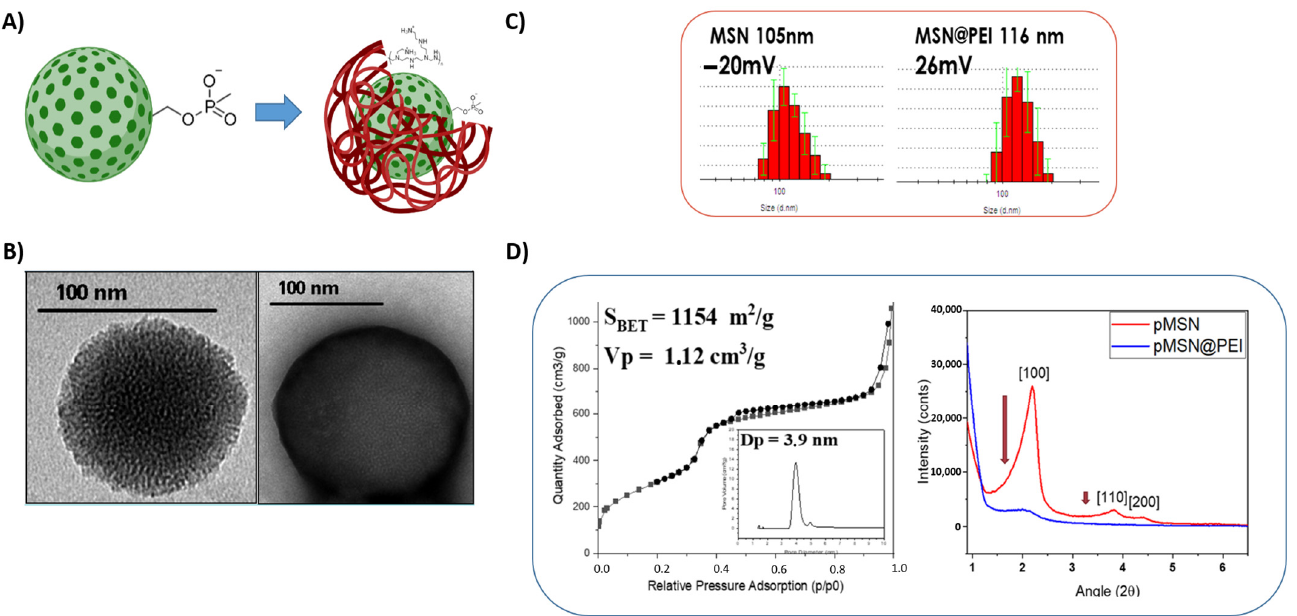
Figure 1. Synthesis and characterization of MSN and MSN@PEI nanosystems. ( A ) Schematic representation of the designed nanocarrier based on mesoporous silica nanoparticles with and without PEI. ( B ) TEM micrographs of the nanoparticles before and after coating with PEI polymer. ( C ) The ζ potential and DLS analysis, ( D ) N 2 adsorption (BET), and X-ray diffraction (XRD) before and after coating with PEI polymer.